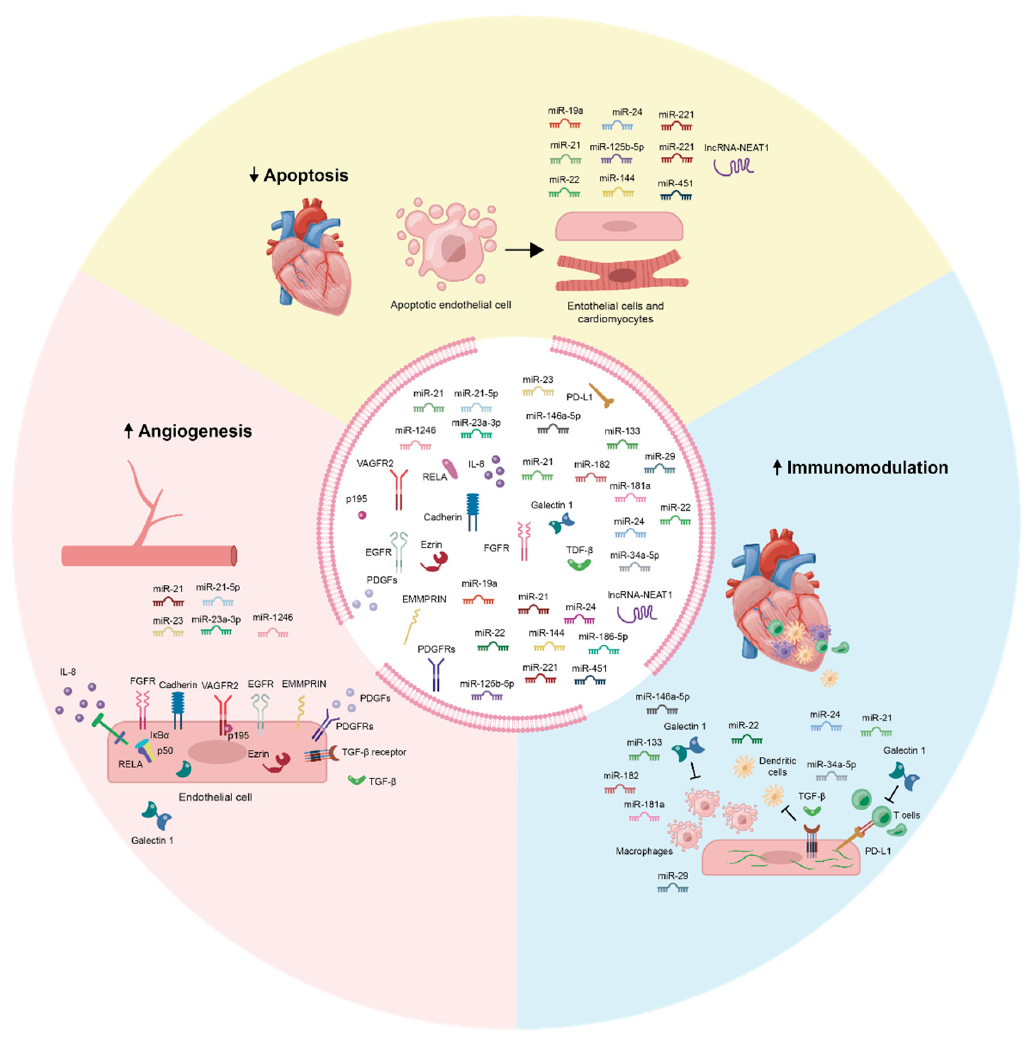
Figure 2. Summary of MSC-Exo molecular cargo and its functions in angiogenesis, apoptosis, and immunomodulation. MSC-Exo treatments improve blood vessel neo-formations through the activation of a wide range of pro-angiogenic pathways in ECs. In parallel, anti-apoptotic effects are induced via bioenergetics modification, principally though the PI3K/AKT and mTOR pathways. Finally, MSC-Exos modify the inflammatory and fibrotic immune responses, creating a microenvironment more accommodating to regeneration and healing. A highly diverse set of molecular cargo (almost solely consisted of miRNA and protein factors) is responsible for the cardioprotective and regenerative effects of MSC-Exos.